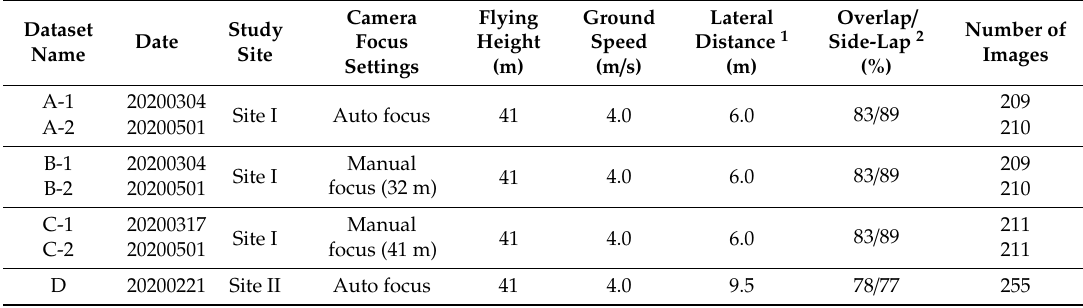
Table 1. Flight configuration and camera settings of the flight missions captured for the experimental